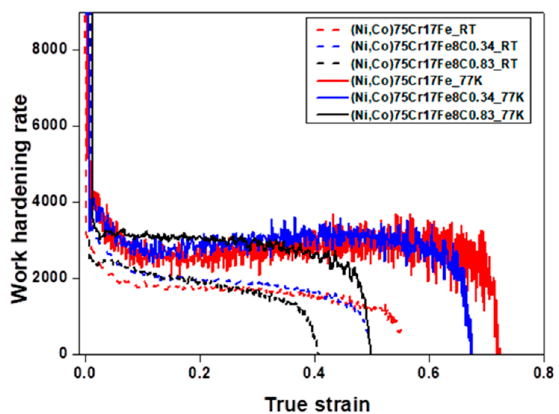
Figure 7. The hardening rates of (NiCo) 75 Cr 17 Fe 8 C x alloys with different carbon contents (0, 0.34 and 0.83 at.%) plotted as a function of true strain at room or cryogenic